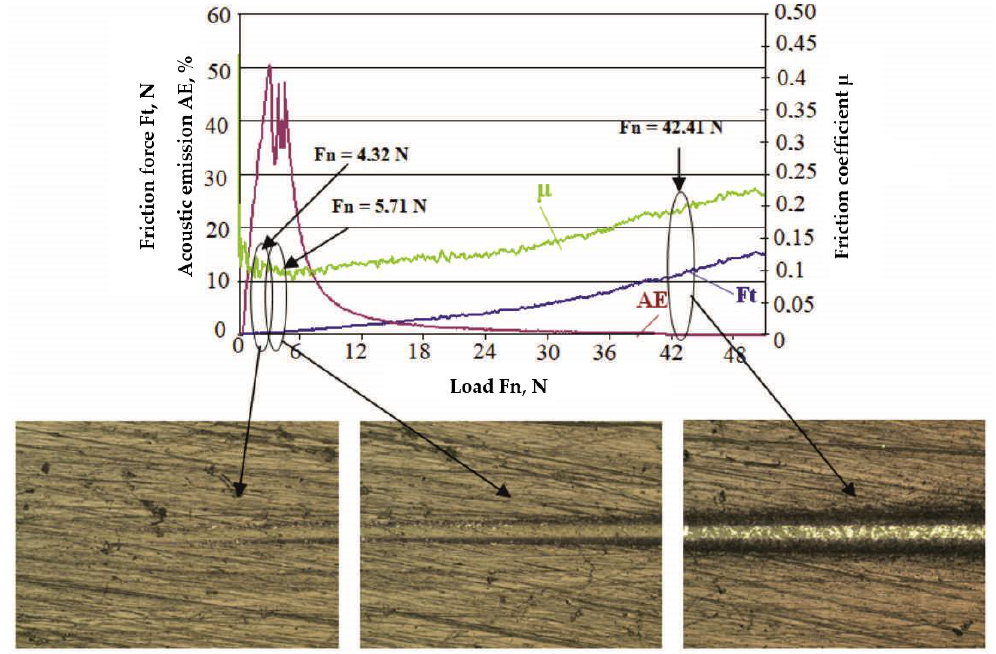
Figure 1. Example scratch tests on the carbon layer deposited by reactive magnetron sputtering (RMS) on the X39Cr13 substrate.